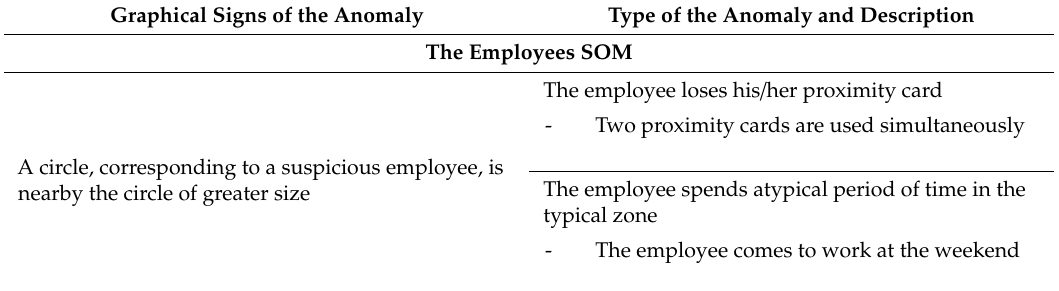
Table 1. Graphical patterns for anomalies.